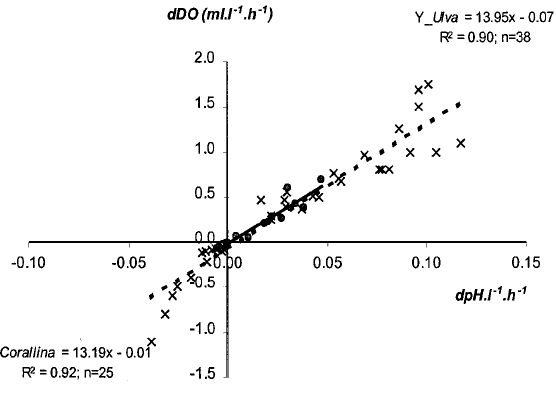
F IG . 4. – Hourly rate of total alkalinity (TA in mEq.l -1 ) per litre of seawater as a function of the biomass (in grams of dry weight, DW) of C. elongata placed in experiment during light (open circle) and dark